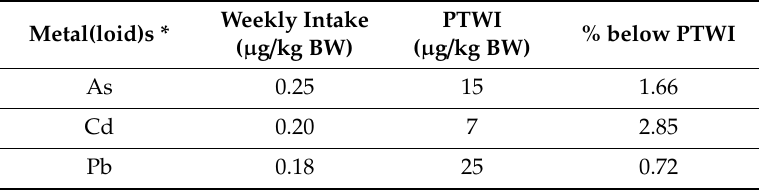
Table 3. Summary of dietary exposure to As, Cd, and Pb from the tea consumption of 5 g, 1.54 days per week relative to PTWIs.